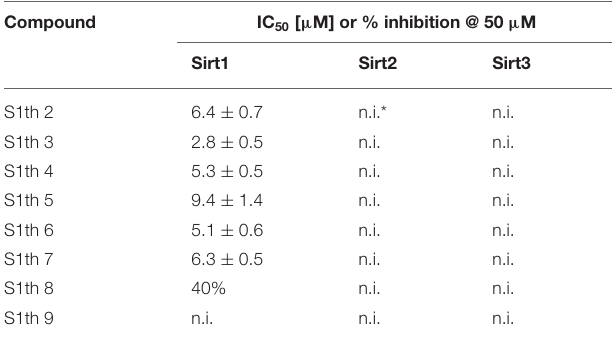
TABLE 2 | Inhibition of class I sirtuins by thiocyanate analogs of 3rd round of virtual screening ( S1th 2–9 ). Compound